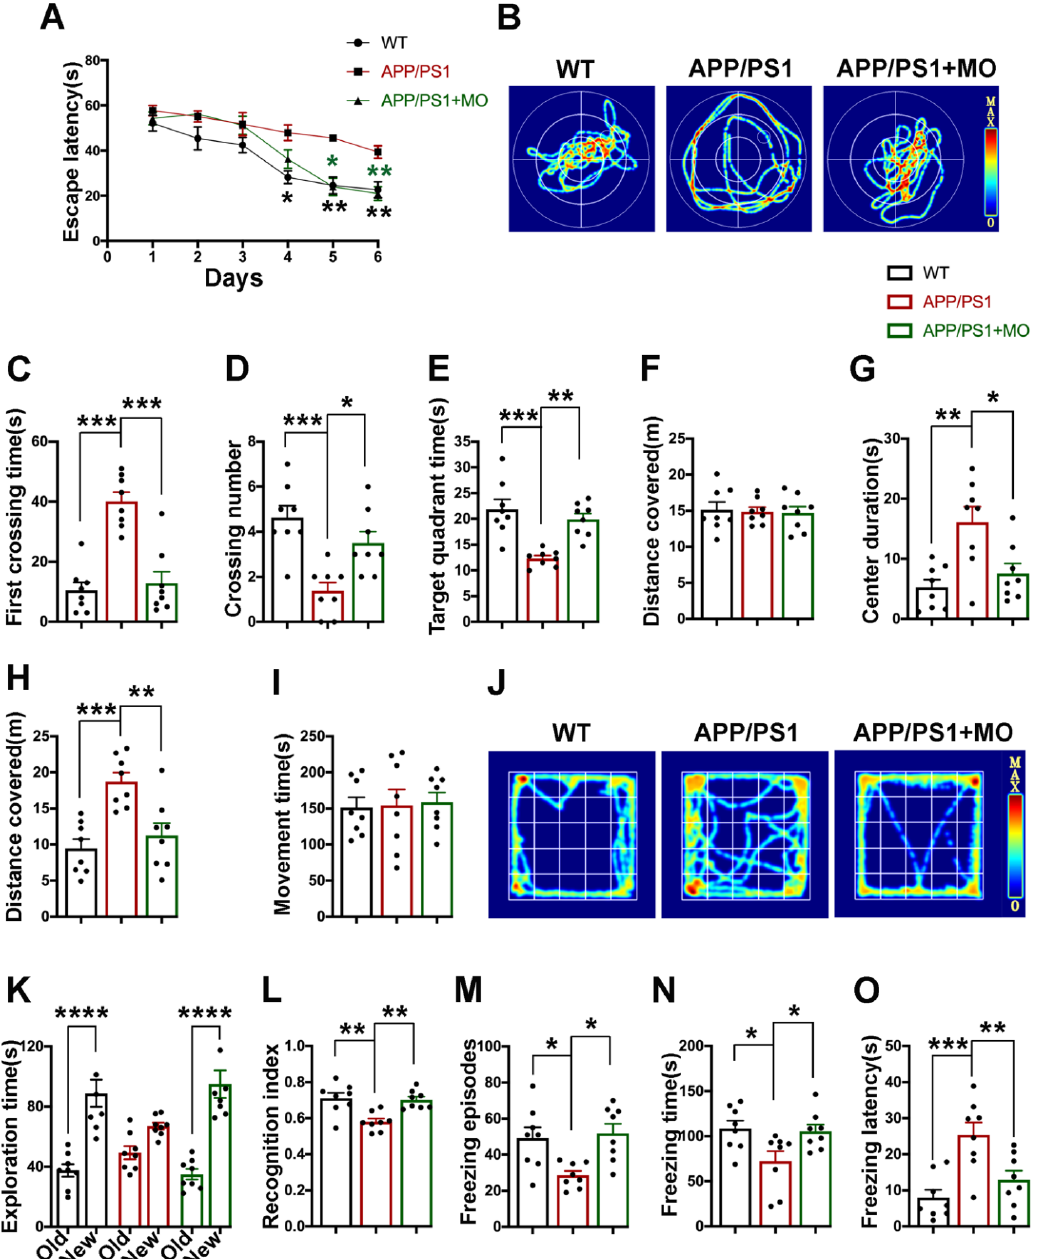
Figure 1. Long-term MO treatment prevents behavioral and cognitive deficits in APP/PS1